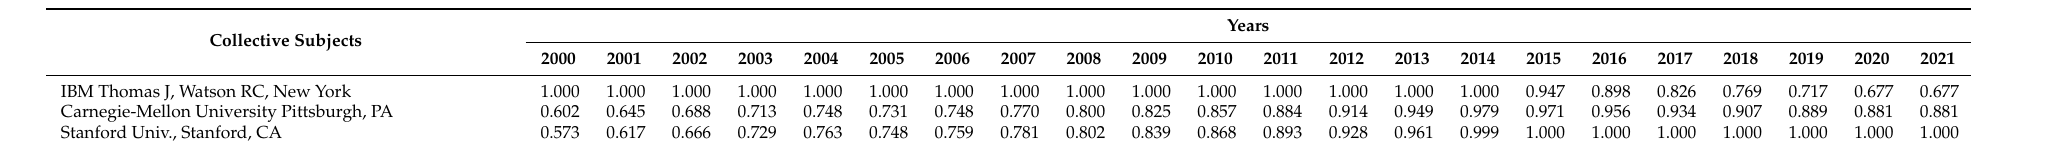
Table A2. Scientific productivity assessments of collective subjects calculated using the TWPR